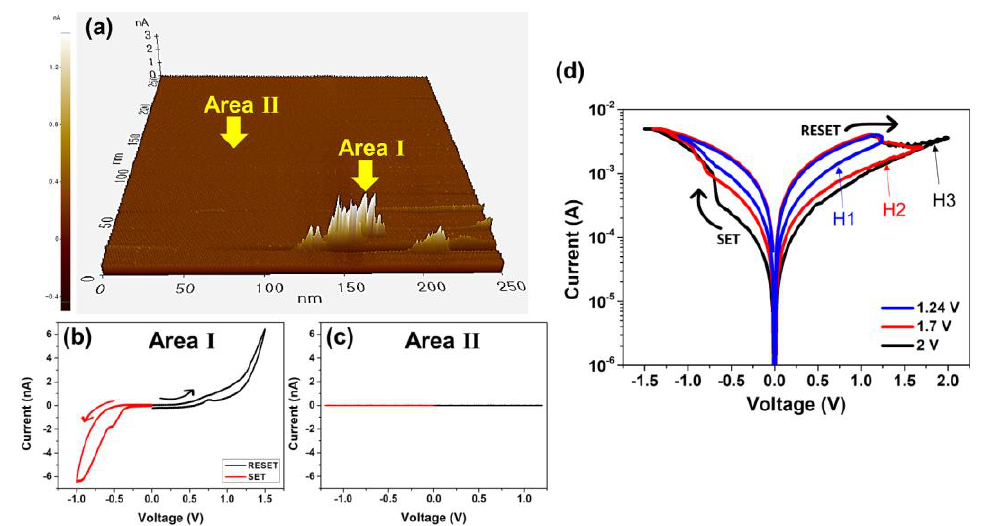
Figure 3. ( a ) Current map for the PCMO memristor in the LRS measured at 1.6 V. Bipolar switching curves obtained from ( b ) area I and ( c ) area II. ( d ) I – V plots of the Pt/PCMO/TiN – Si memristor measured at different reset voltages. Nanomaterials 2021 , 11 , x FOR PEER REVIEW